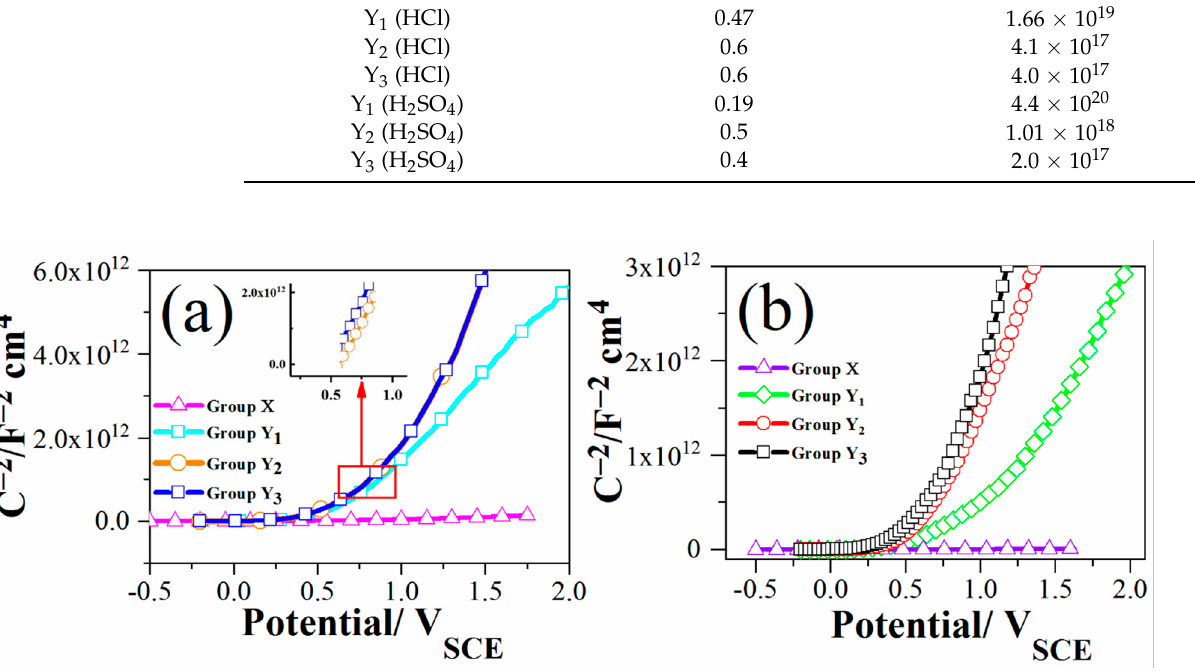
Table 4. The values of prepared groups of flat band potential E FB and donor density N D . Samples